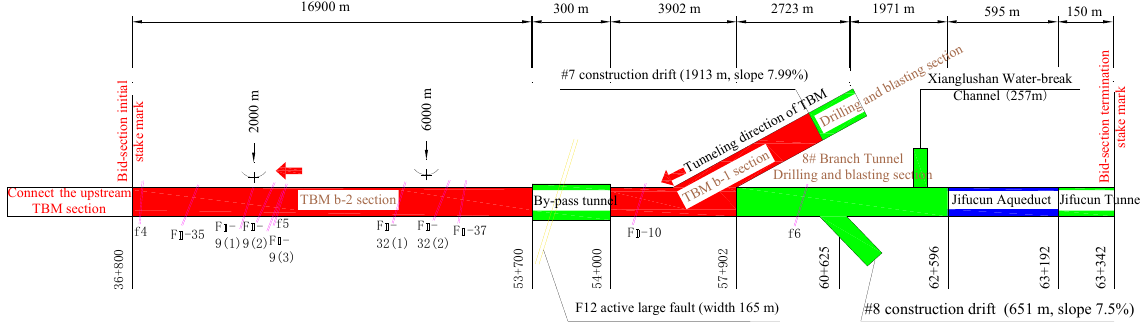
Figure 2. Project overview of downstream segment TBMb of Xianglushan Tunnel.The red refers to TBM section; the green refers to drilling and blasting section; the blue refers to Jifucun Aqueduct.